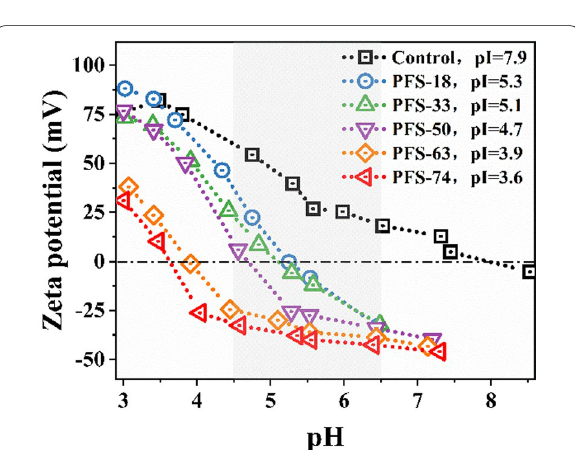
Fig. 5 Isoelectric points (pIs) of leather samples retanned using PFS with different DSs (neutralizing pH